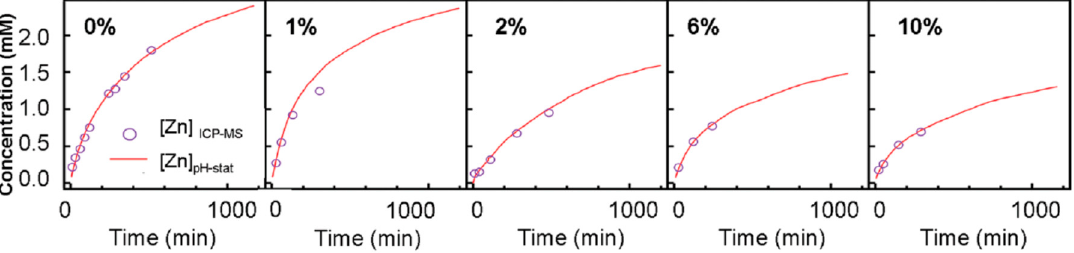
Figure 7. Zinc release in an aqueous solution at pH 7 by the dissolution of Fe-doped ZnO nanoparticles at different doping levels. Adapted from ref. [128] .